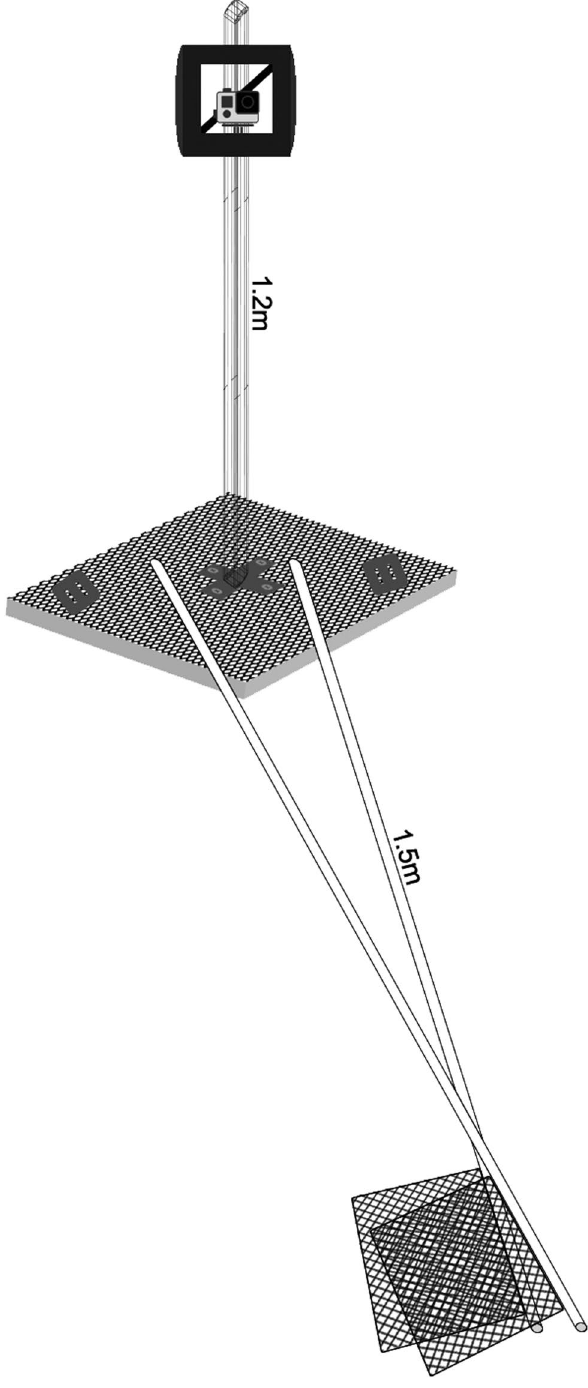
Figure 2. Baited Remote Underwater Video Survey unit with GoPro Hero 4 mounted, bait arm, and bait